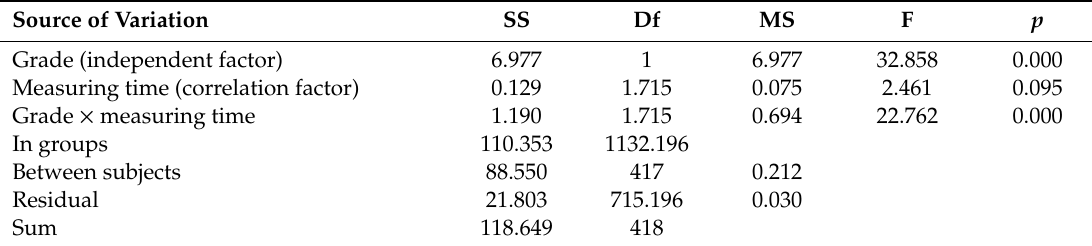
Table 5. Two-factor mixed-design ANOVA results for left eye visual